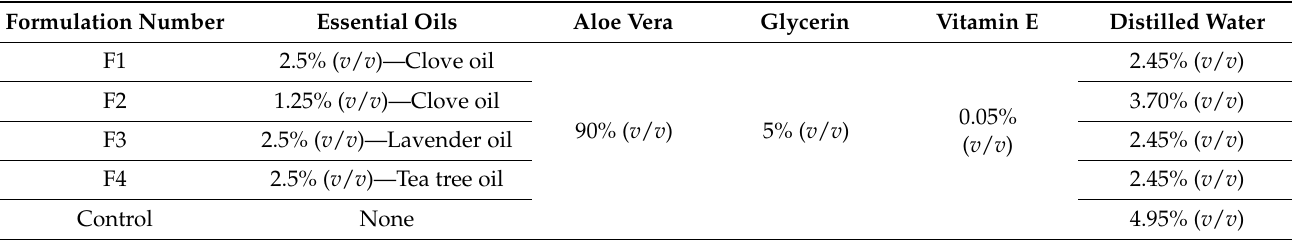
Table 1. The composition of prepared hand sanitizer